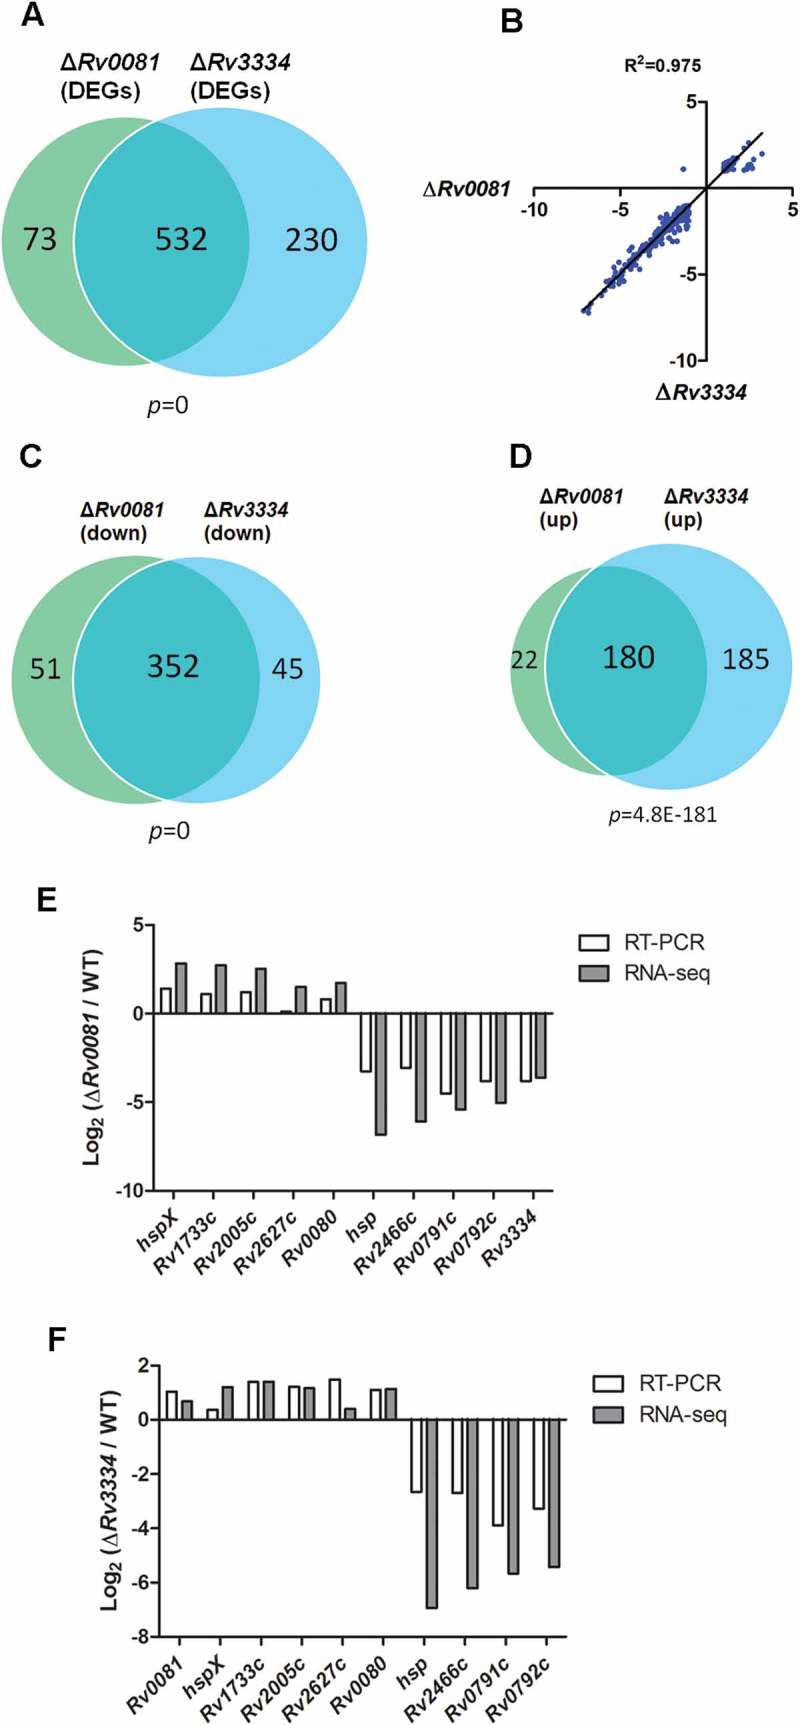
The gene expression profiles of ΔRv0081 and ΔRv3334 are highly similar. (a) Overlap of DEGs in hypoxic cultures of ΔRv0081 and ΔRv3334, each compared to WT cultures under hypoxia. (b) The expression levels of 532 overlapped DEGs in ΔRv0081 and ΔRv3334 were compared and plotted. The correlation coefficient (R [2]) was calculated. (c) Overlap of the downregulated genes in hypoxic cultures of ΔRv0081 and ΔRv3334, compared to WT hypoxic culture. (d) Overlap of the upregulated genes in hypoxic cultures of ΔRv0081 and ΔRv3334, compared to WT hypoxic culture. The hypergeometric p values were calculated for each overlap analysis. (e & f) RT-PCR validation of RNA-seq data. Twelve genes including Rv0081, Rv3334 and sigA were selected for RT-PCR analysis. The expression levels of each gene relative to sigA in hypoxic cultures were determined by RT-PCR and compared between WT and the mutant strains.